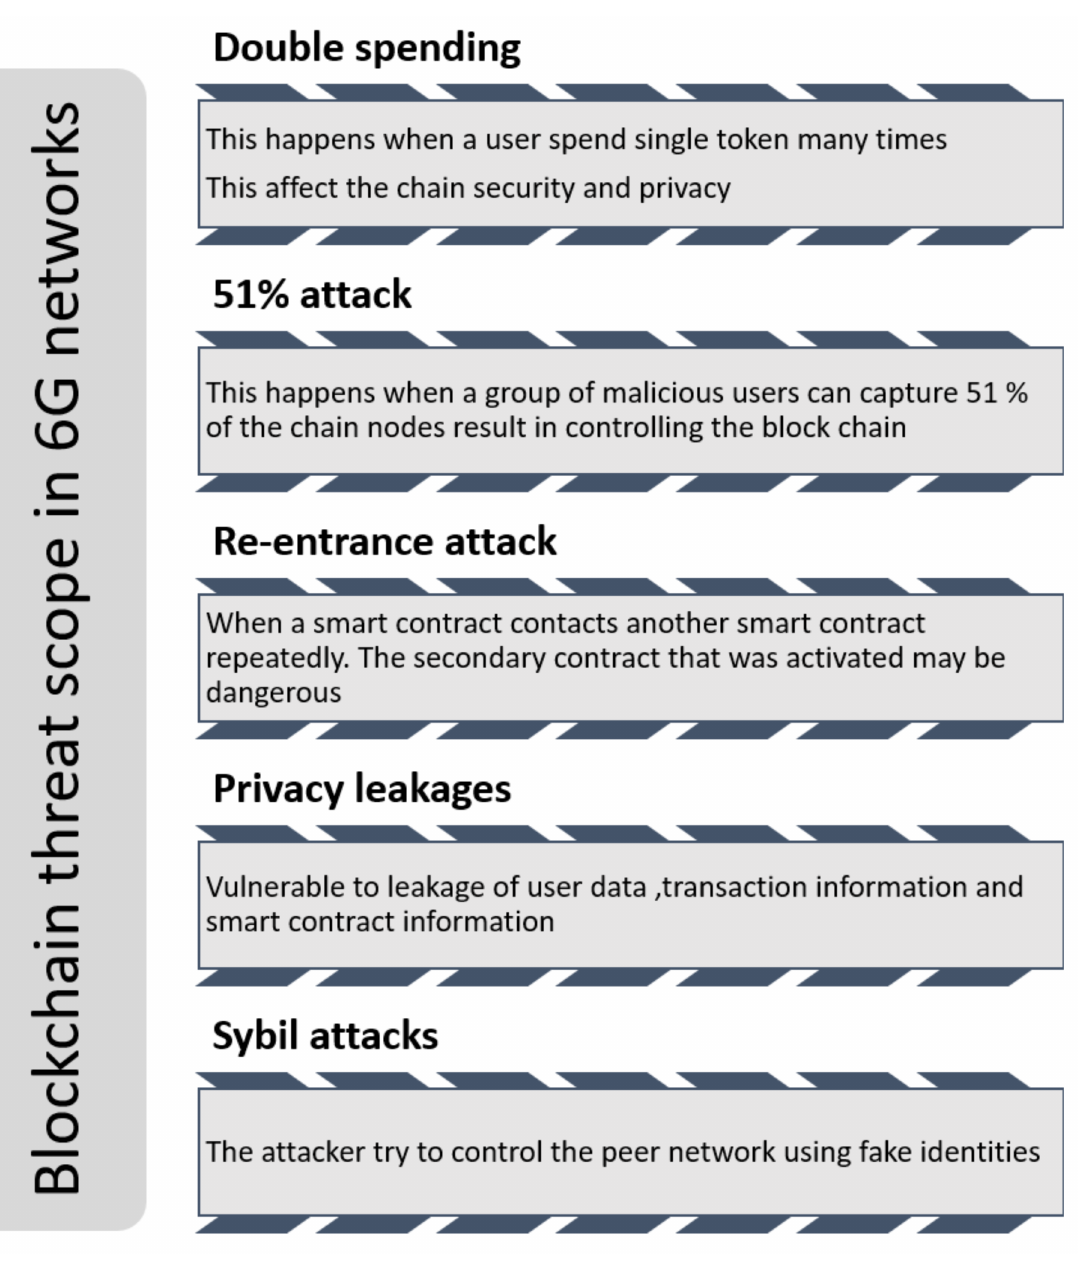
Figure 8. The 6G blockchain technology attacks and